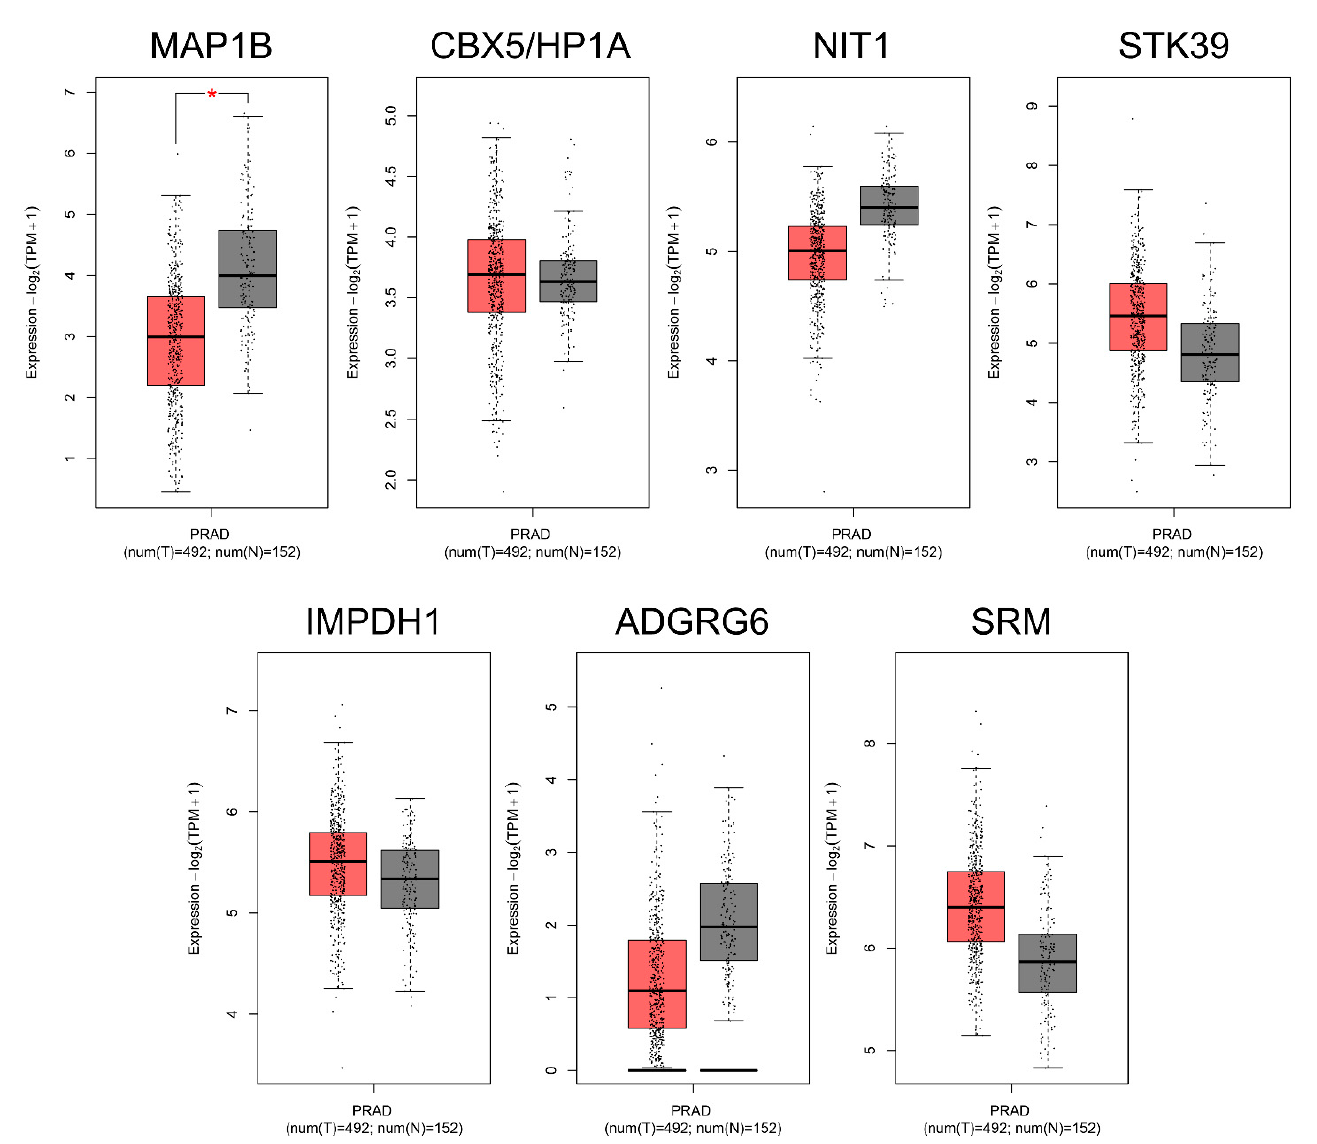
Figure 5. Gene expression analysis performed with GEPIA2 for the predicted miTGs in prostate adenocarcinoma (PRAD) samples (red, T = 492) and normal tissue (grey, N = 152) from TCGA and GTEx projects. Gene expression (log2(TPM + 1)) for MAP1B, CBX5/HP1A, NIT1, STK39, IMPDH1, ADGRG6 and SRM. Significant difference shown with an asterisk: * p -value ≤ 0.01.